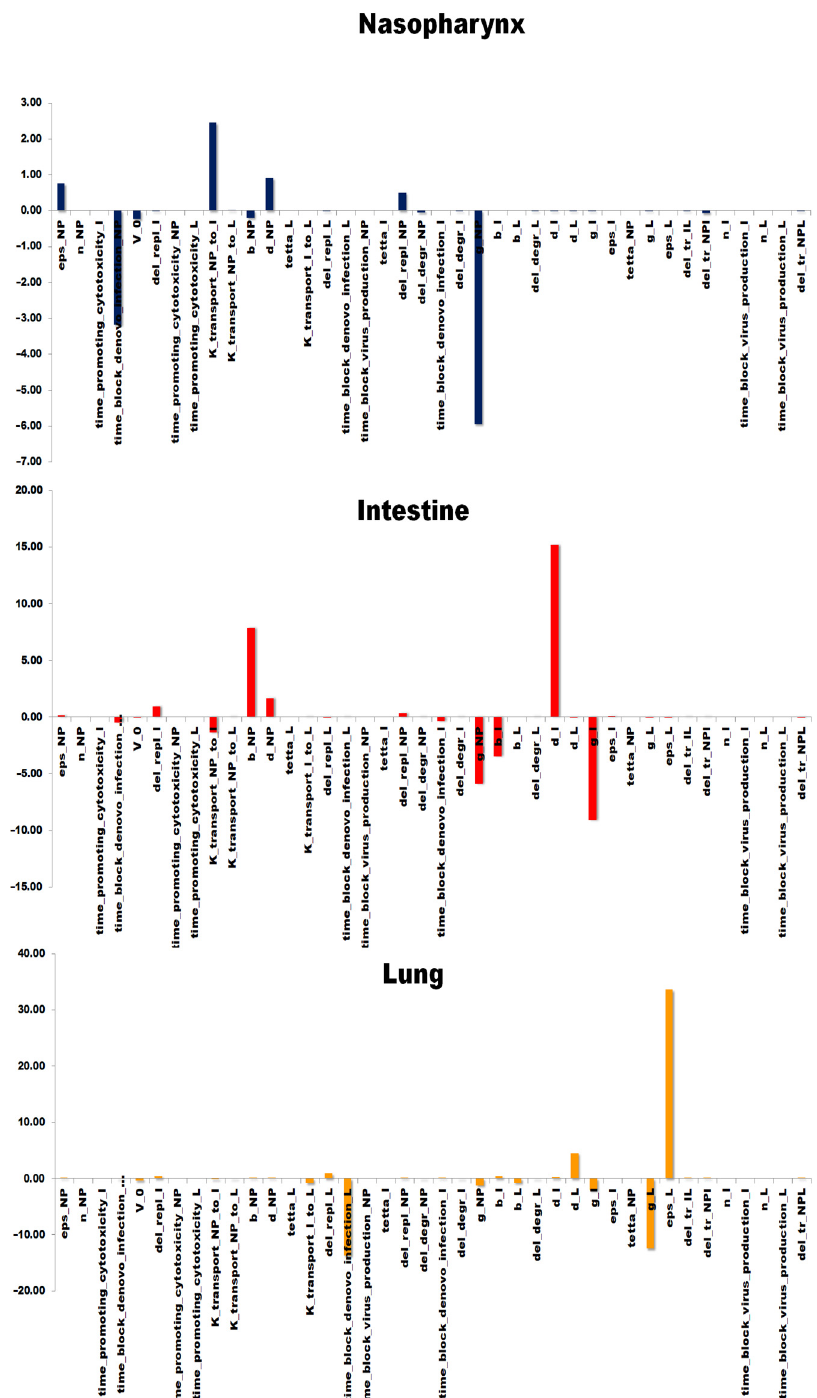
Figure 7. Sensitivity analysis of the model. The target variables in the analysis correspond to the target cell ratios in each compartment, where the column height indicates the scaled sensitivity’s value of the variable to a certain model parameter.